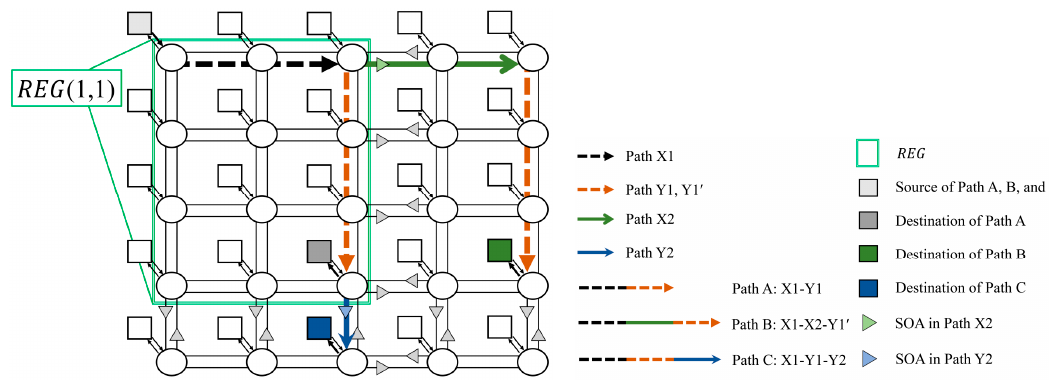
Figure 10. Example of determining the minimum SOA gain considering traffic paths across the top-leftmost non-SOA region.